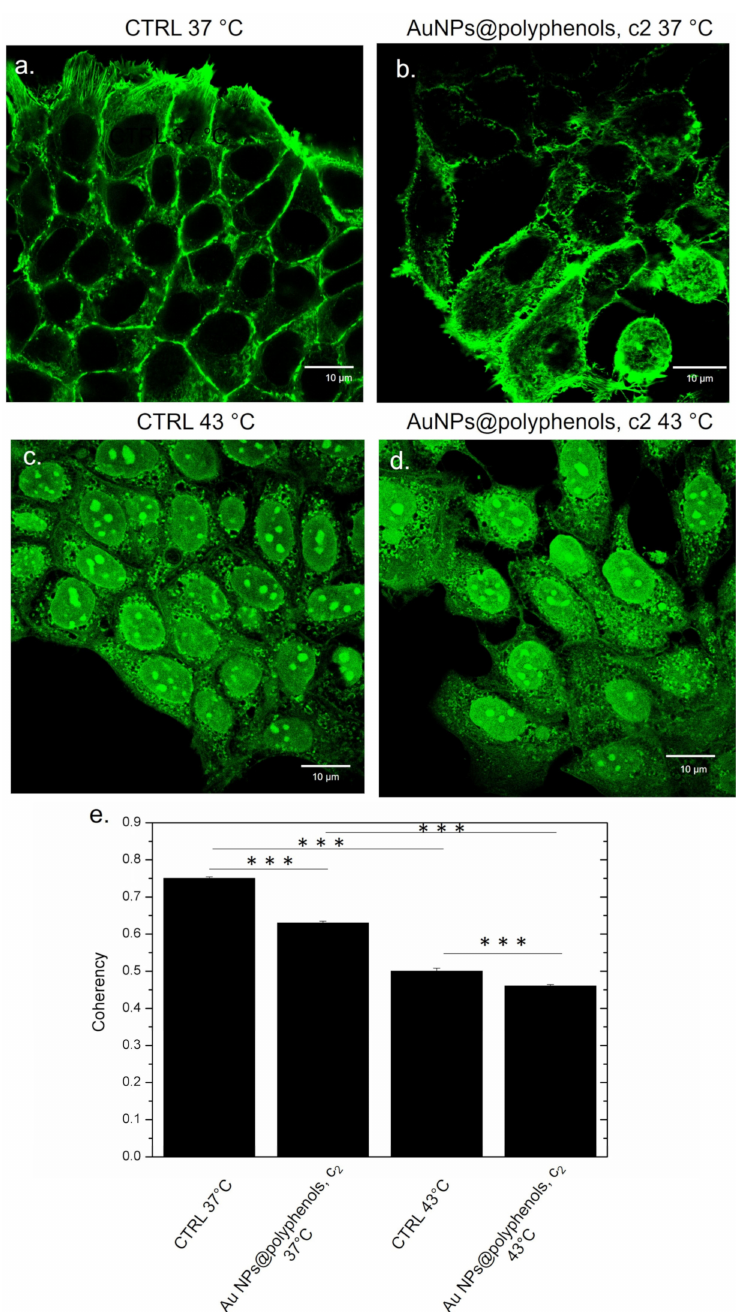
Figure 12. Effect of Au NPs@polyphenols on the actin network in MCF-7 exposed to the c2 of Au NPs@polyphenols at 37 ◦ C and 43 ◦ C for 48 h, following the procedure described in the section, Materials (ph.2.8). ( a ) Untreated cells at 37 ◦ C; ( b ) cells incubated with Au NPs@poyphenols at c2 and 37 ◦ C; ( c ) cells treated with 43 ◦ C, ( d ) cells treated with heat and Au NPs@polyphneols at 43 ◦ C. The cells were fixed and then stained with Phalloidin–FITC. 2D images of cortical actin were acquired by a Zeiss LSM700 (Zeiss) confocal microscope, equipped with an Axio Observer Z1 (Zeiss) inverted microscope, using a × 100, 1.46 numerical aperture oil immersion lens. All data were processed using the ZEN software. ( e ) The coherency values calculated on the confocal acquisitions ( a – d ) were expressed as the mean value and relative SD using ImageJ (calculation on 15 cells). The mean values and their standard deviations are reported in the histograms. Data were statistically significant for *** p <